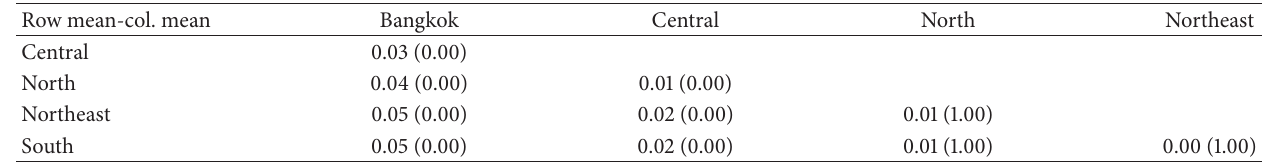
Table 8: Comparison of mean AAI of male elderly by region